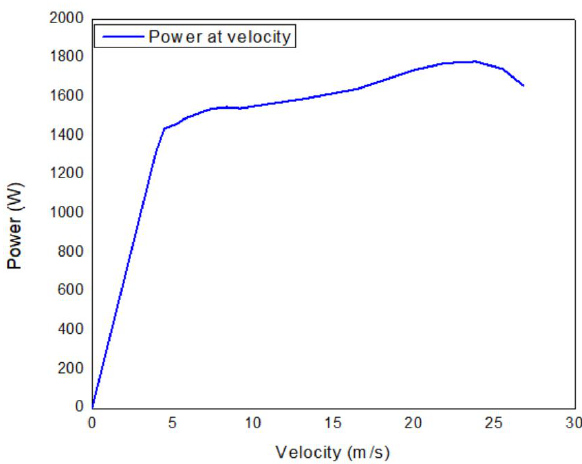
Figure 23. Power at different velocities.